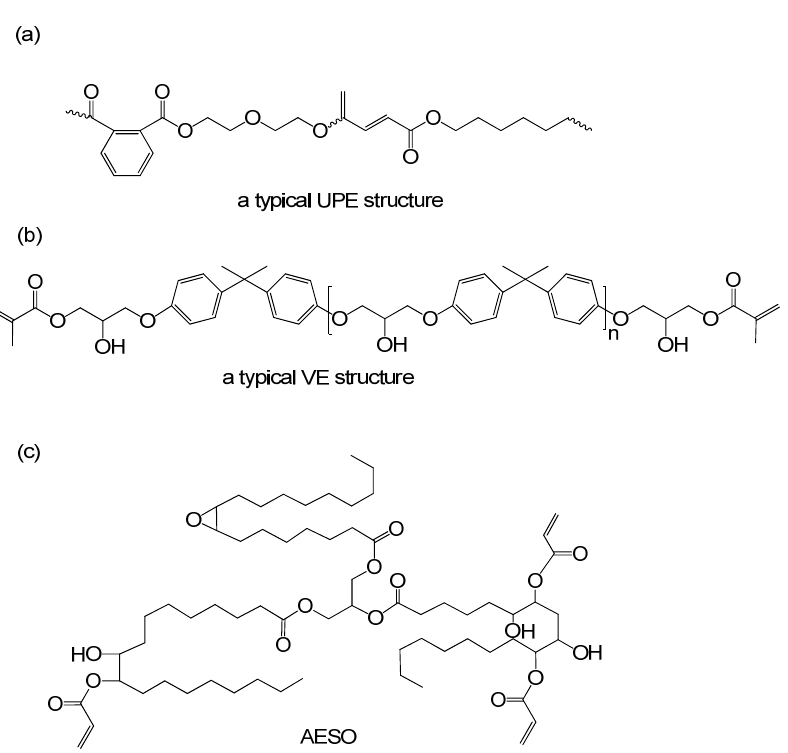
Figure 1. Representative structure of ( a ) unsaturated polyester (UPE), ( b ) VE [3] and ( c ) acrylated epoxidized soybean oil (AESO) [6].